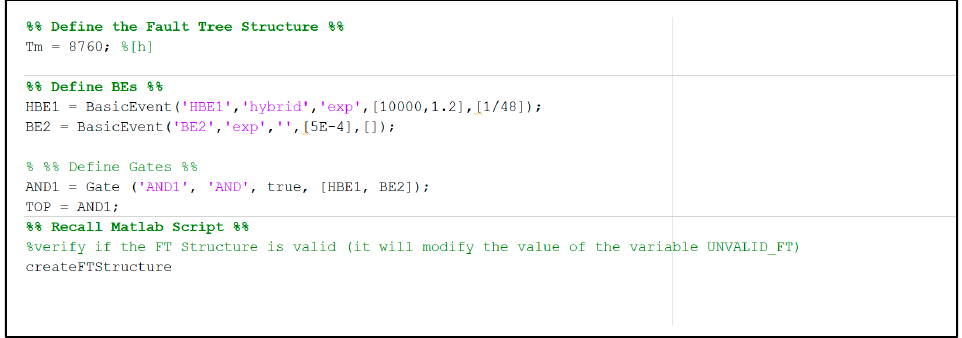
Figure 2. Example of fault tree with the SHyFTOO library.